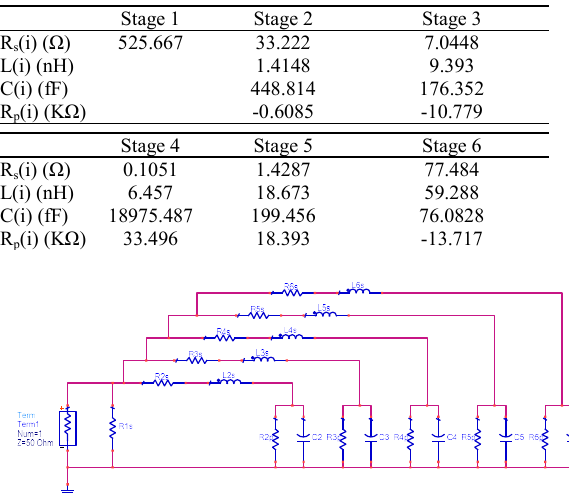
Table 3: RLC parameters for the spice circuit with CRR defected